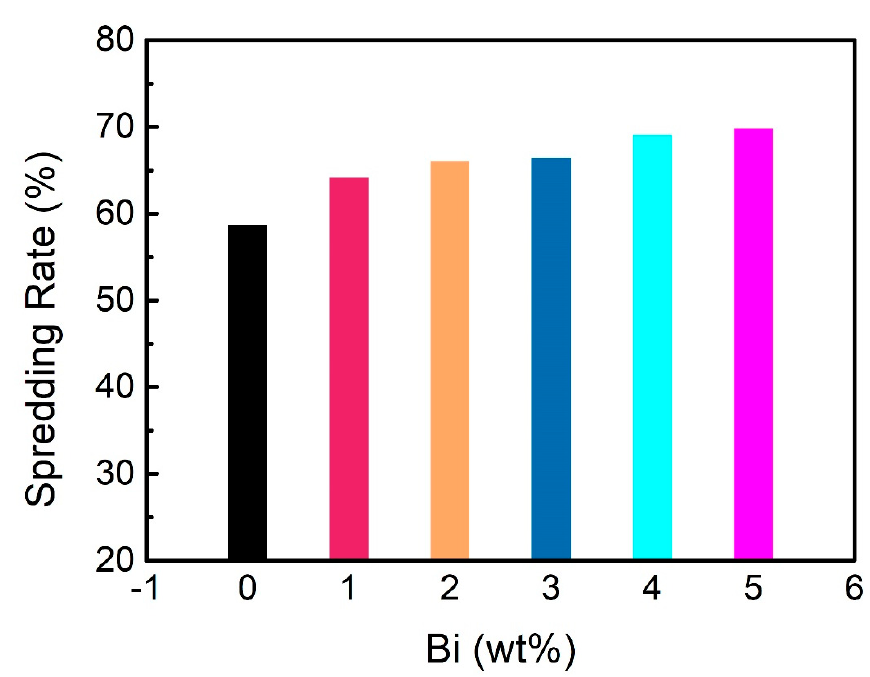
Figure 6. Spreading rate of the Sn-9Zn-xBi solder alloys on the Cu